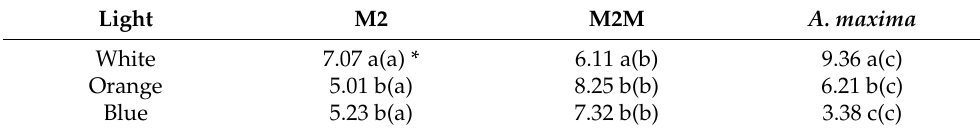
Table 1. Average lipid content (g 100 g − 1 ± RSD DW) after irradiation of the three strains. Light